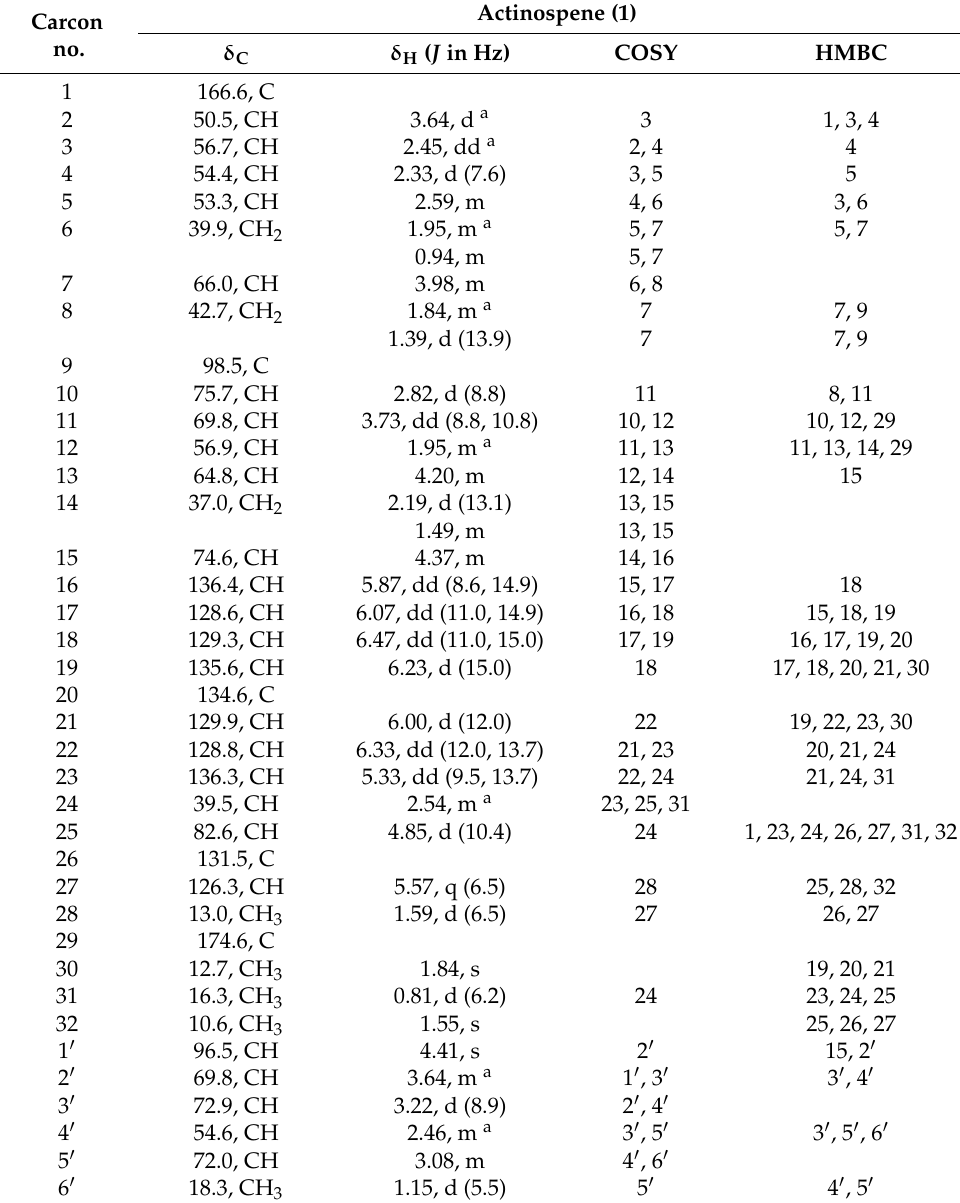
Table 1. NMR spectroscopic data for actinospene (1) in DMSO-d 6 ( δ H , 600 MHz; δ C , 150 MHz).